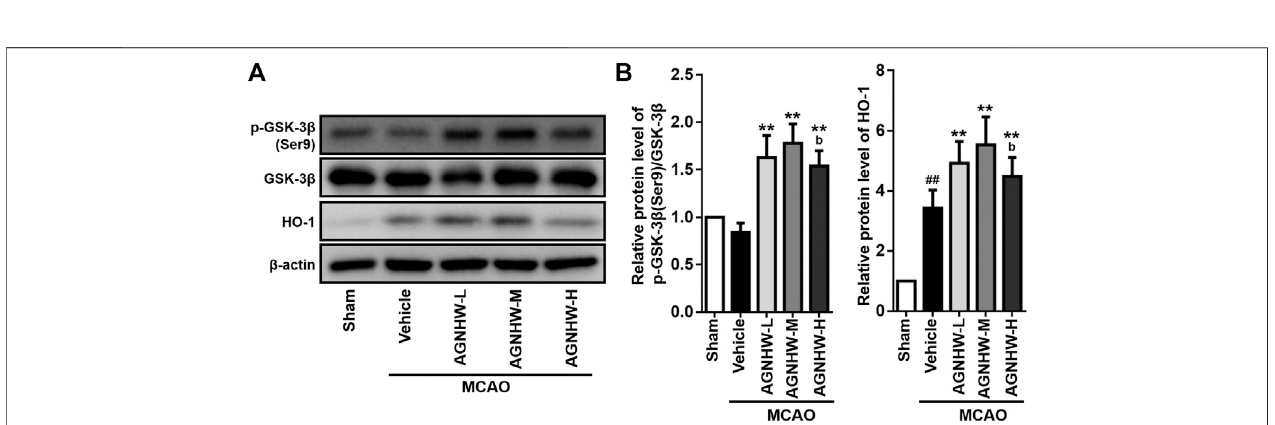
FIGURE 4 | Pre-treatment with AGNHW enhanced activation of GSK-3 β /HO-1 pathway. Western blot analysis (A) and the normalized protein levels (B) of the indicated protein markers of the GSK-3 β /HO-1 pathway in the infarct area of the ischemic cortex in MCAO rats with or without AGNHW pre-treatment. AGNHW pre- treatment signi fi cantly increased the ratio of p -GSK-3 β (Ser9)/GSK-3 β and the expression of HO-1 in the infarct area of MACAO rats. Full length blots are shown in Supplementary Figure S1 . N (cid:2) 4 rats per group. Data are means ± S.D. ## p < 0.01, compared with sham group; ** p < 0.01, compared with vehicle group; b P < 0.05, compared with AGNHW-M